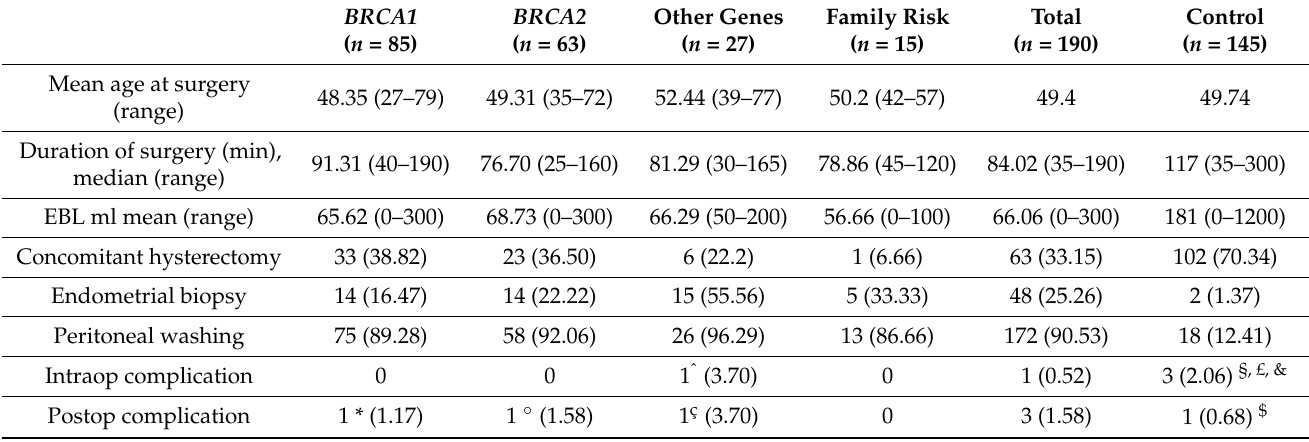
Table 2. Surgical characteristics of the study